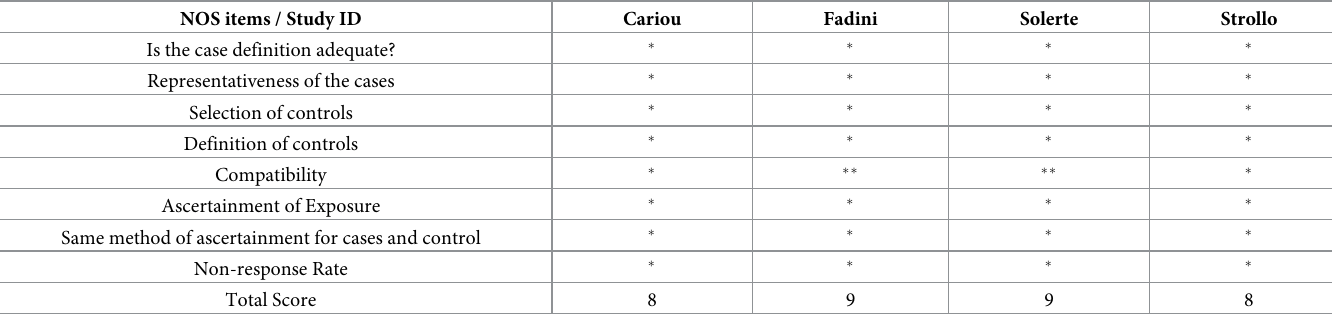
Table 2. Risk of bias assessment of the included studies according to the Newcastle-Ottawa Scale (NOS).